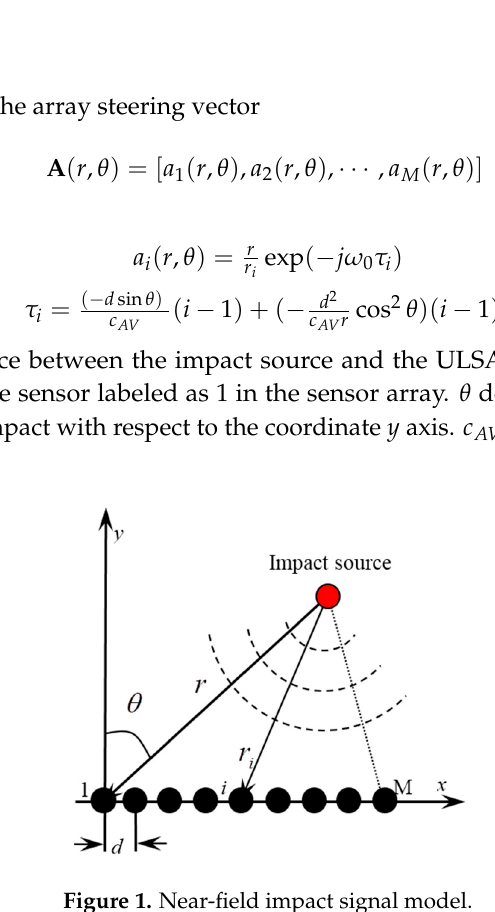
Figure 1. Near-field impact signal model.